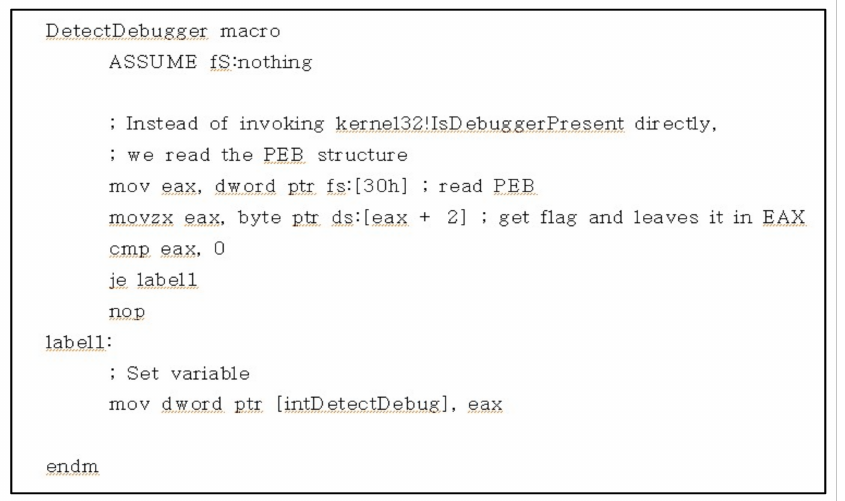
Figure 2. Assembly code to detect the